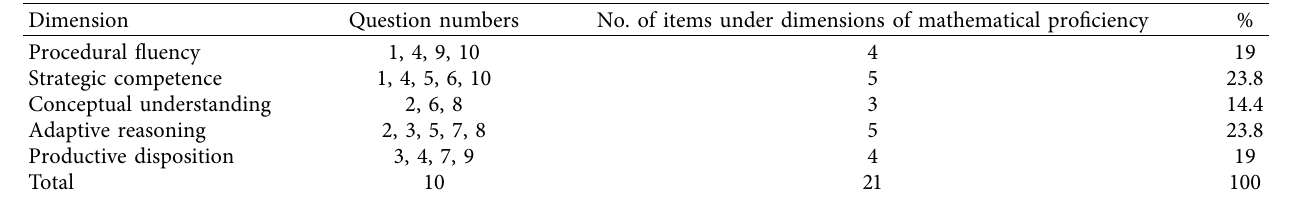
Table 2: Specifications of the mathematical proficiency test.